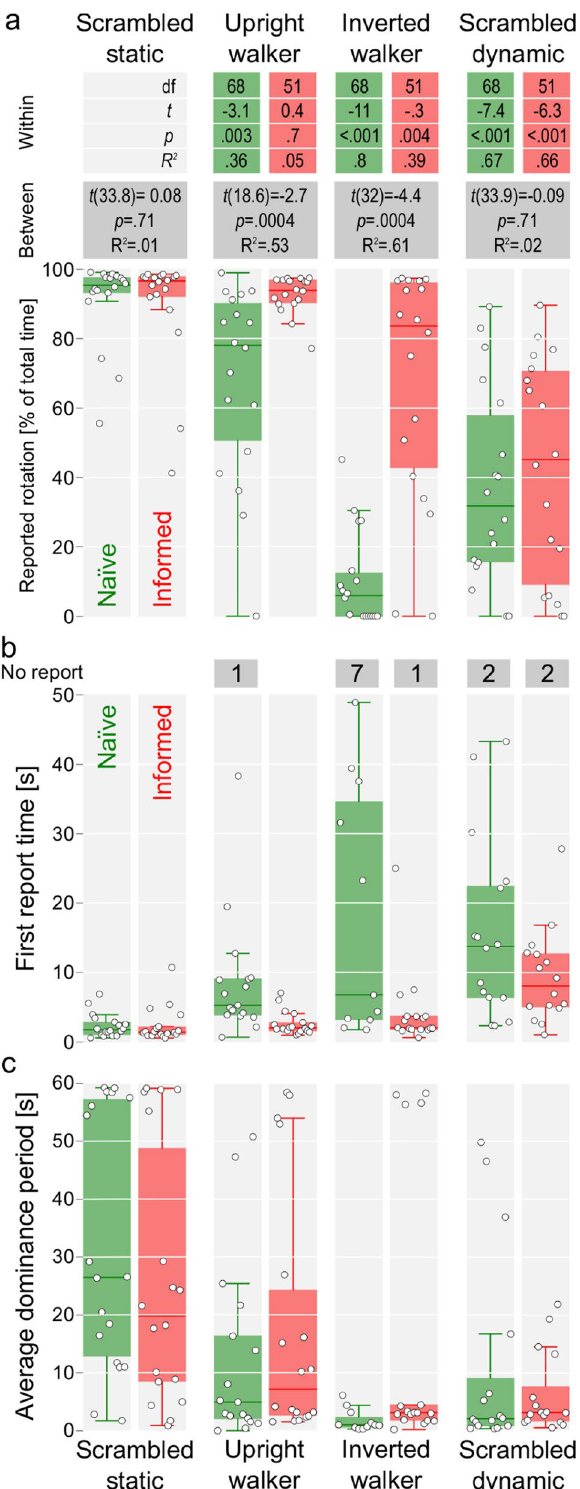
Figure 1. Results of the main experiment for the Naïve (green, left) and Informed (red, right) groups. Circles represent the individual observers. ( a ) Percentage of the total time when observers reported the perception of rotation. The within table above the plot shows the comparison of three conditions with dynamic objects to the Scrambled static condition. The comparison was performed separately for each group via a linear mixed model with the condition as a fixed effect and observers as a random effect. The between table above the plot shows the comparison for each condition between the groups using a paired permutation test. ( b ) Time of the first report. Numbers above the plot show the number of observers with no reports of the rotation. ( c ) Average dominance period duration (geometric